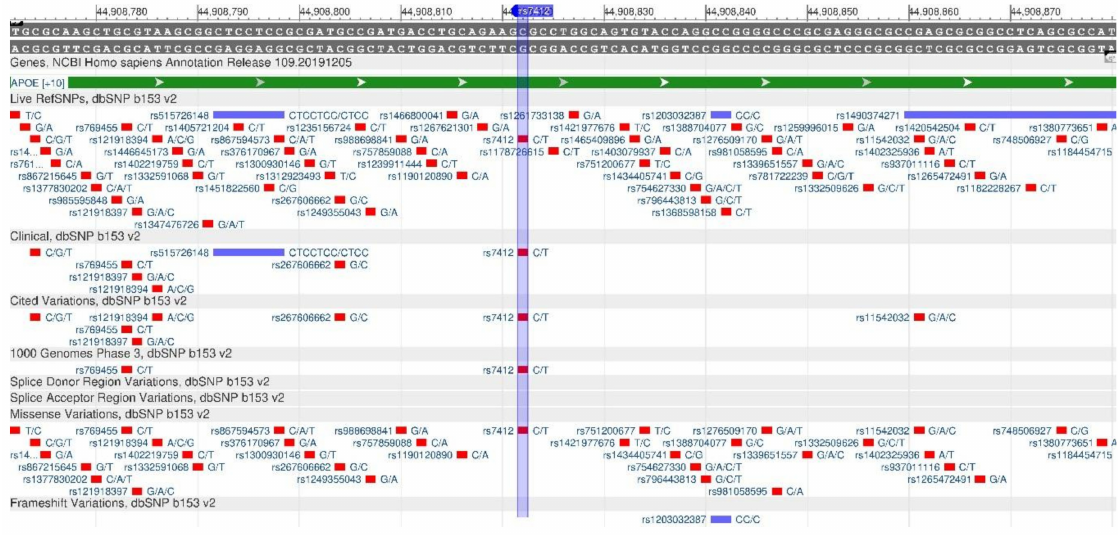
Figure 13. ApoE gene region (located on the long (q) arm of chromosome 19) containing the oligonucleotide polymorphism